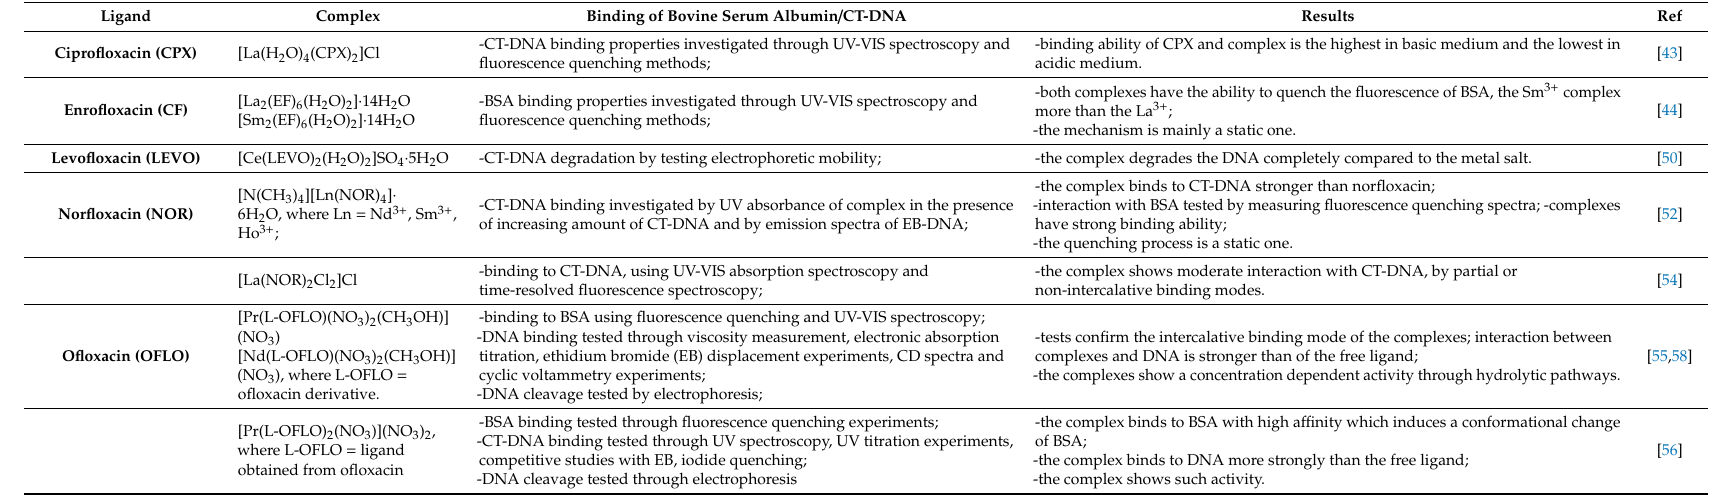
Table 3. Calf-thymus (CT-DNA) and bovine serum albumin (BSA) binding tests for quinolone complexes with lanthanide ions. Ligand Binding of Bovine Serum Albumin / CT-DNA Results -CT-DNA binding properties investigated through UV-VIS spectroscopy and fluorescence quenching methods;